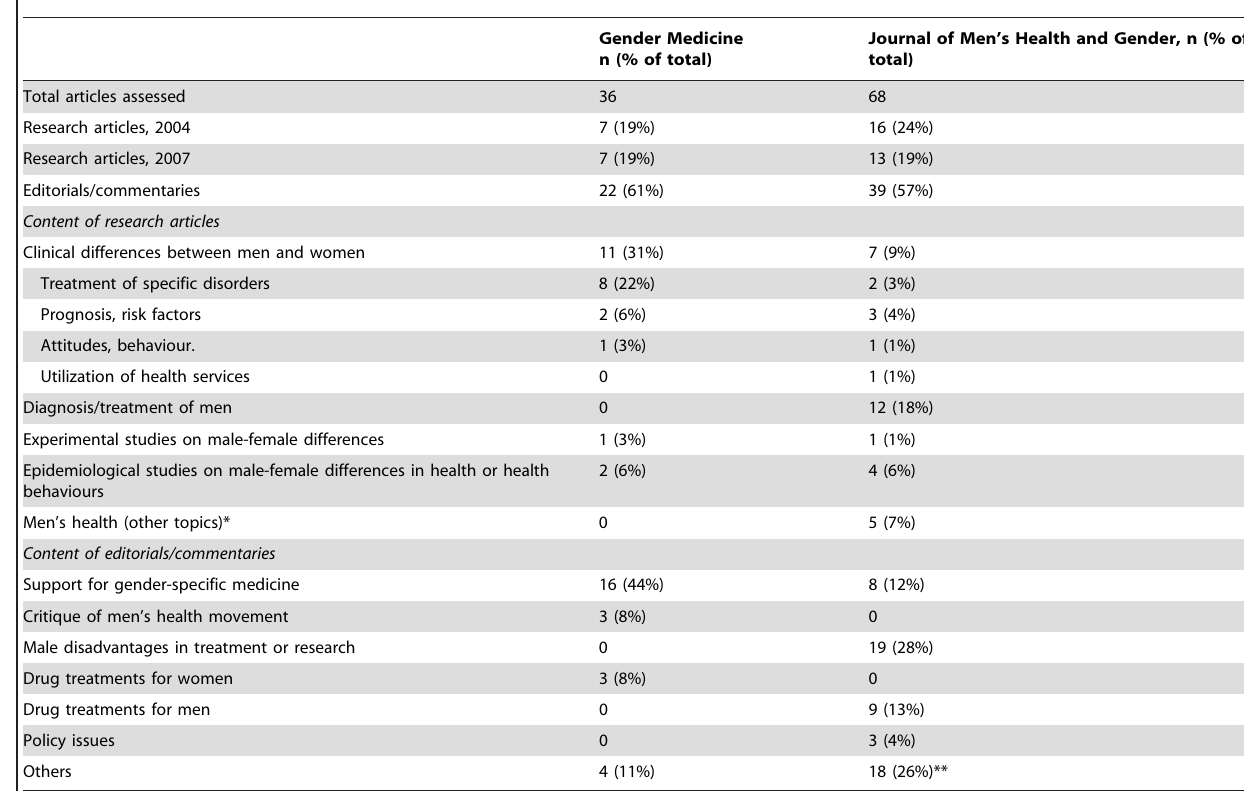
Table 1. Description of the material as well as the content (more than one content coded per paper) of the papers in the two journals.